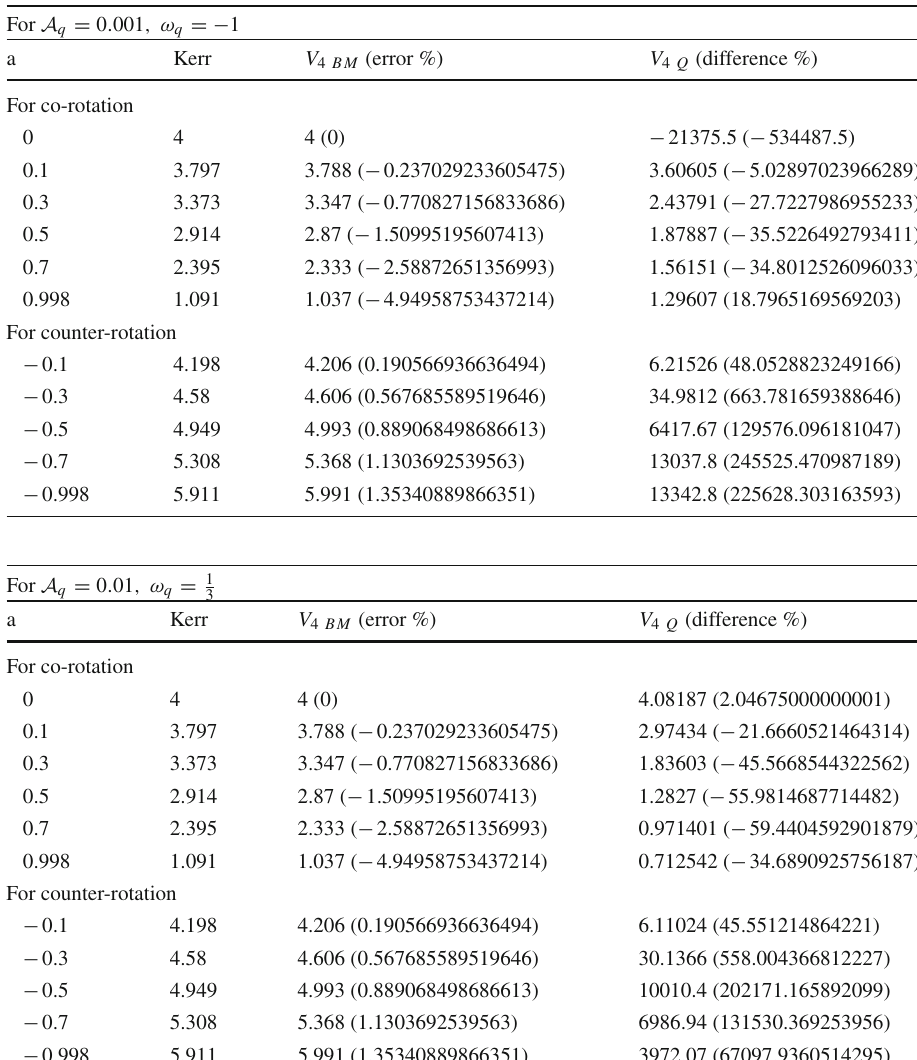
PNPs for very low DE effect in phantom barrier